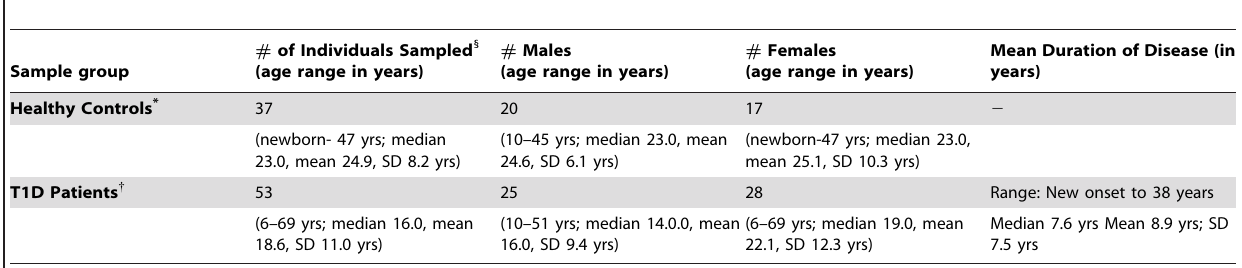
Table 1. Human Subject Population Characteristics for Peripheral Blood Samples collected over the 3 year study period (2006– 2009).